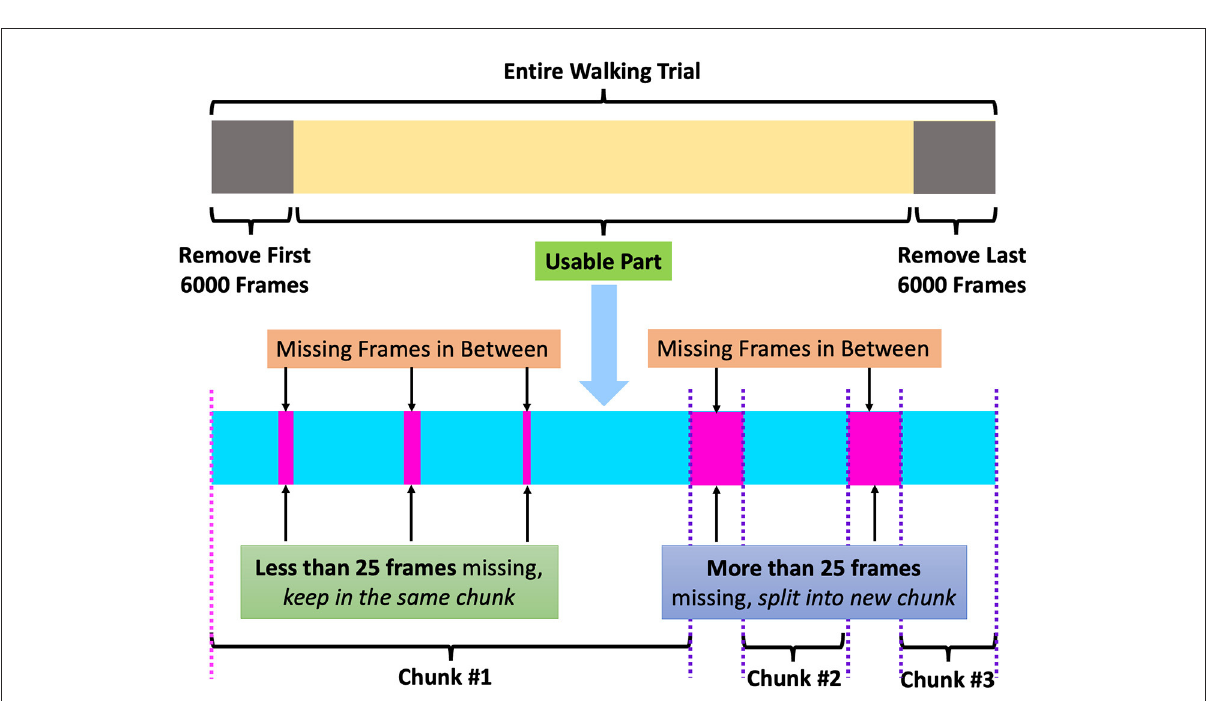
FIGURE9 Splitting a walking trial into chunks for straightness and angle